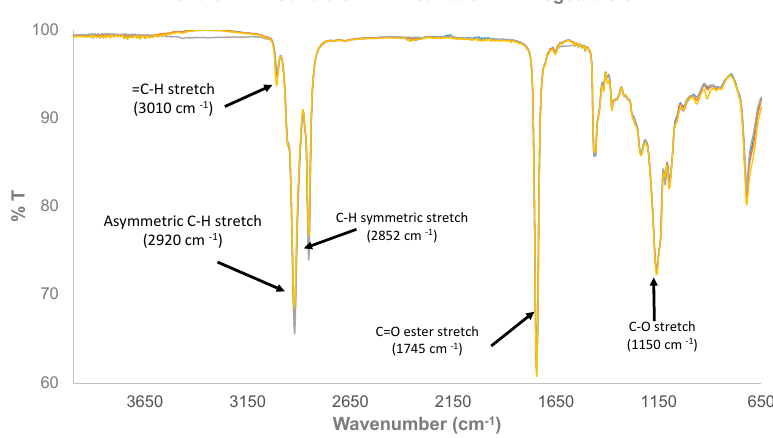
Figure 1. FTIR spectra of pure highly refined peanut oil, vegetable oil (VO), canola oil (CO), and almond oil (AO).